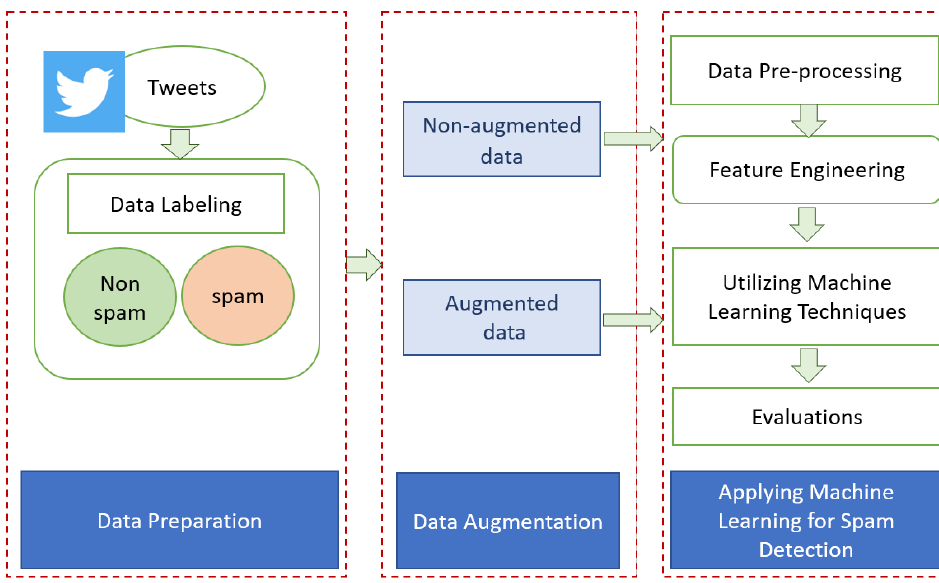
Figure 1. Proposed Framework for Enhancing Arabic Spam Detection